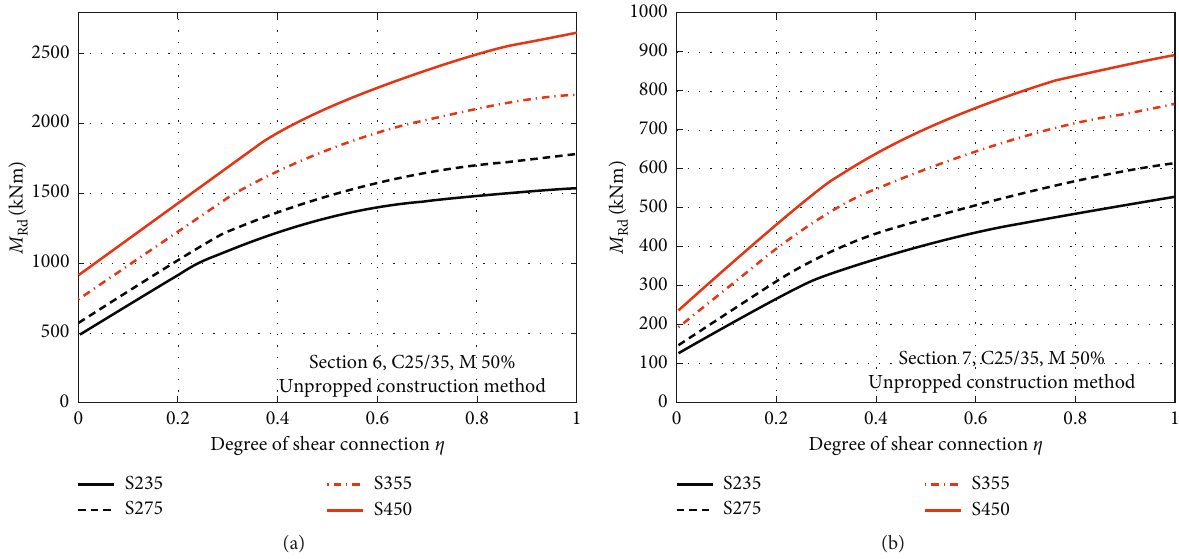
Figure 16: Effect of variation of class of steel on resisting bending moment-degree of shear connection relation. Unpropped construction method. (a) Section 6 C25/35 M50% and (b) Section 7 C25/35